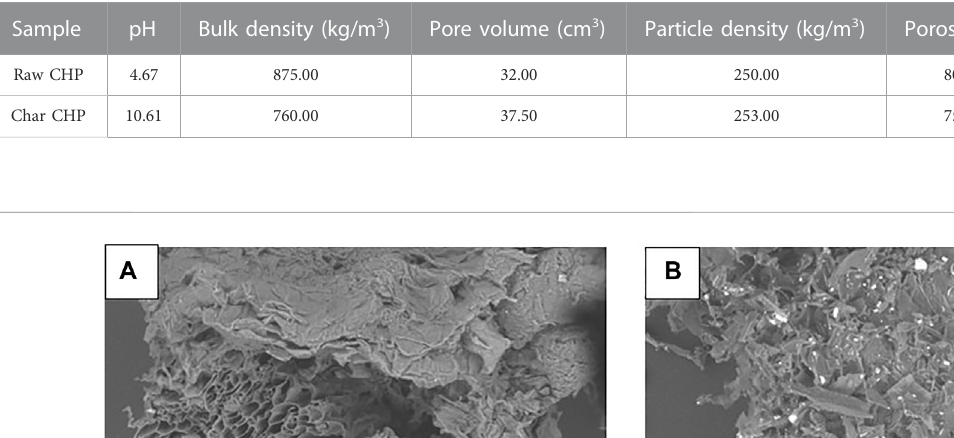
TABLE 1 Physical characteristics of CHP.